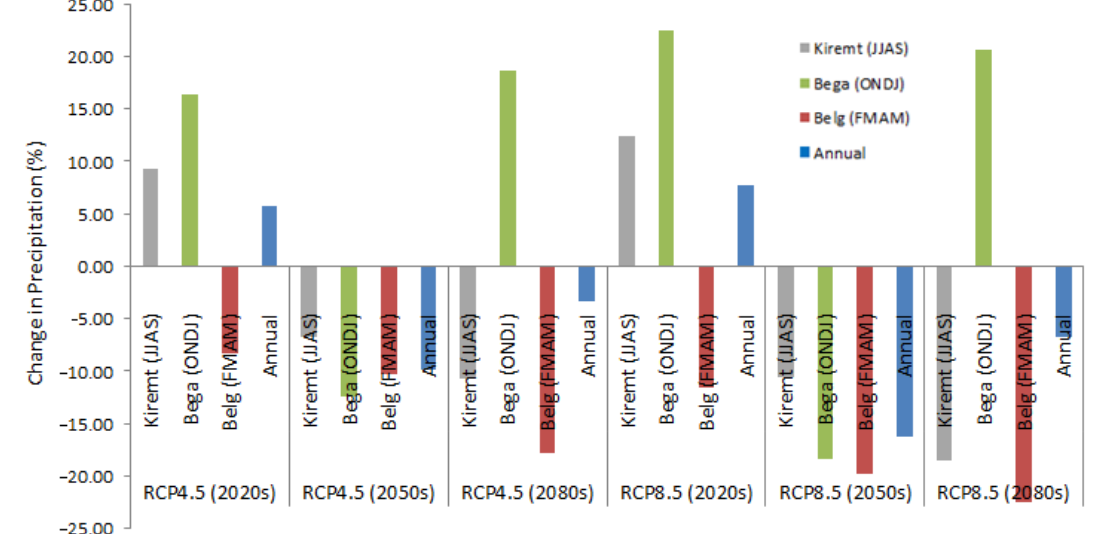
Figure 8. Seasonal and annual change in rainfall for three time periods under RCP4.5 and RCP8.5.